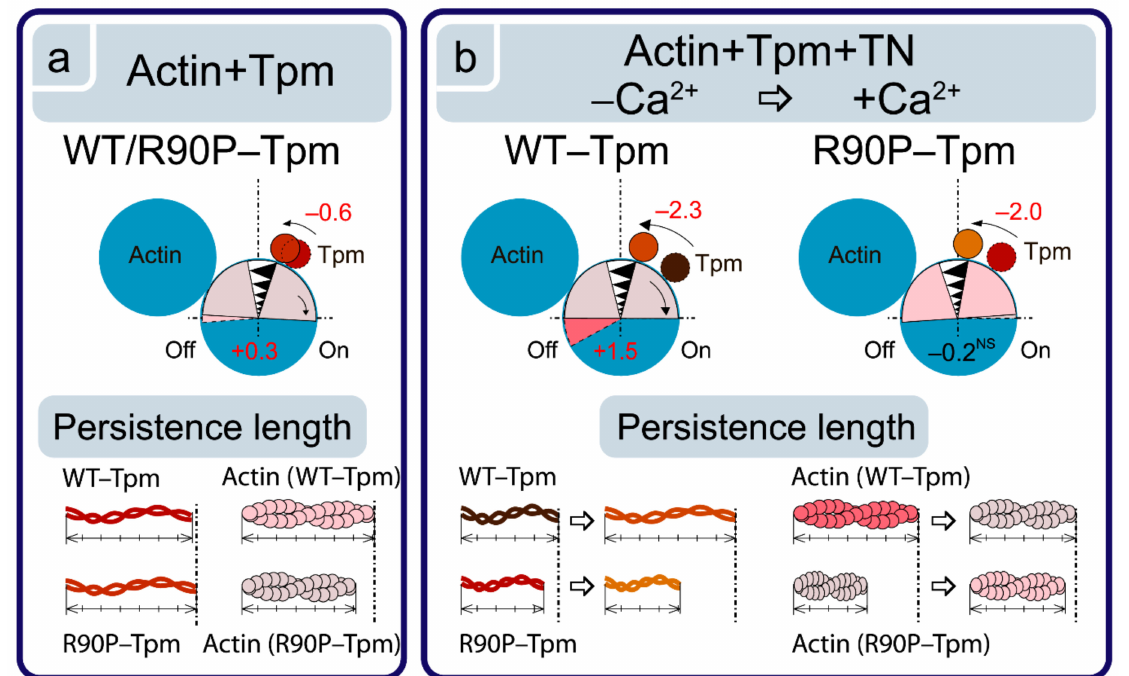
Figure 5. Schematic explanation of the changes in the tropomyosin (Tpm) position, angular orientation of the actin monomer, and persistence lengths of the Tpm strands and actin filaments due to the R90P substitution in Tpm. The information was obtained from the calculation of the value for Φ E (the angle of orientation of the emission dipoles of the fluorescent probes bound to Tpm or actin) and of the value for ε (the bending stiffness; shown here as the alterations in the persistence length of the Tpm strands and actin filament drawn to scale). Ghost fibers were composed of actin and Tpm ( a ) or of actin, Tpm, and TN ( b ). The Tpm position and actin monomers orientation are affected by the R90P mutation and are typical for the shift of Tpm to the inner domains of actin, and for the switching of actin monomers on (clockwise rotation). The mutation decreases the persistence lengths of Tpm and actin. The R90P replacement reverses the changes in the persistence lengths of Tpm and actin that occur in response to the rising Ca 2+ concentration ( b ). Designations: the changes in Φ E between the states at a high and a low Ca 2+ are shown by numbers, and the direction of the rearrangements is depicted by arrows. The non-significant change in Φ E is marked with superscript “NS”. Different localization of Tpm and conformational states of actin and respective persistence lengths are depicted by different colors. Red for numbers is used when the changes are typical for the transition of the complex to the activated